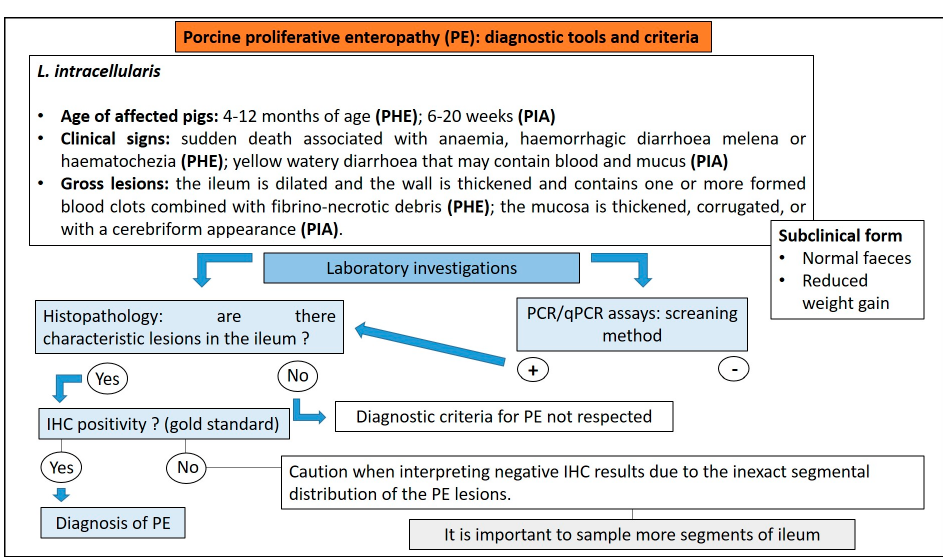
Figure 25 Figure 25. Diagnostic algorithm for the diagnosis of PE in